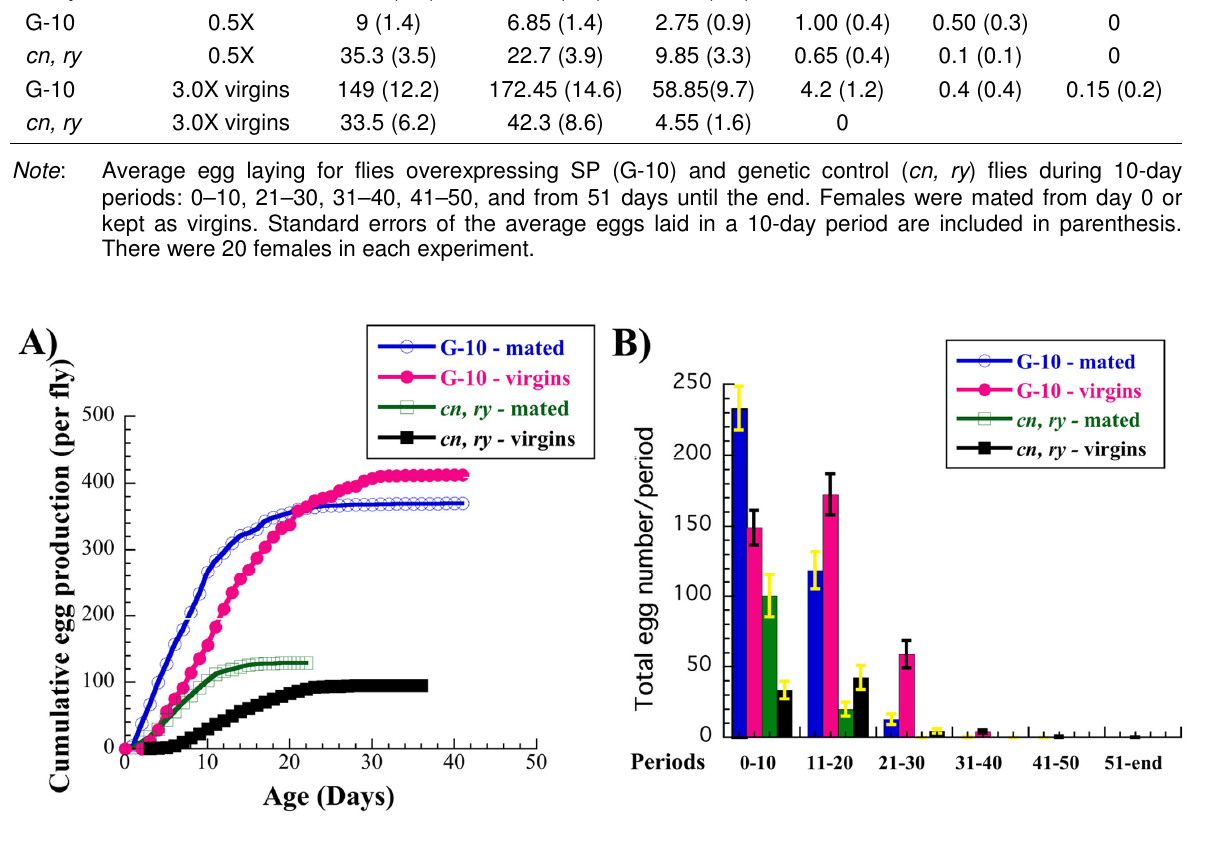
eggs laid by cn, ry females (G-10 = 385.2; cn, ry = 80.3; z = 7.47; p < 0.001) (Tables 1 and